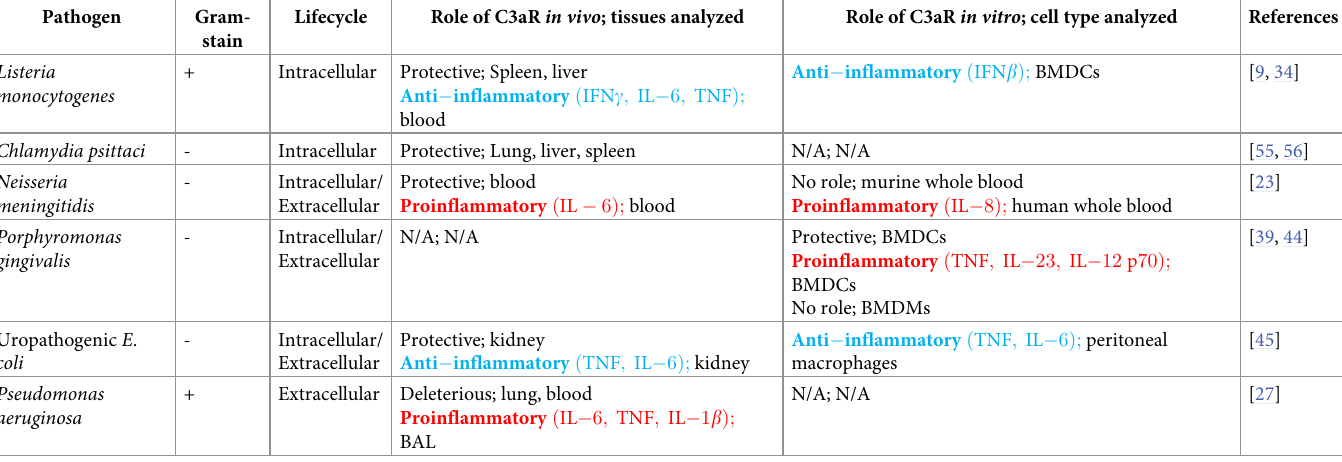
Table 1. Summary of C3aR-dependent phenotypes in bacterial infection